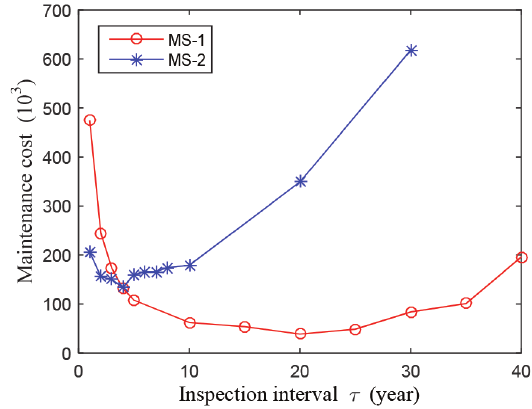
Figure 9. Comparison of MS-1 and MS-2 under the same inspection interval